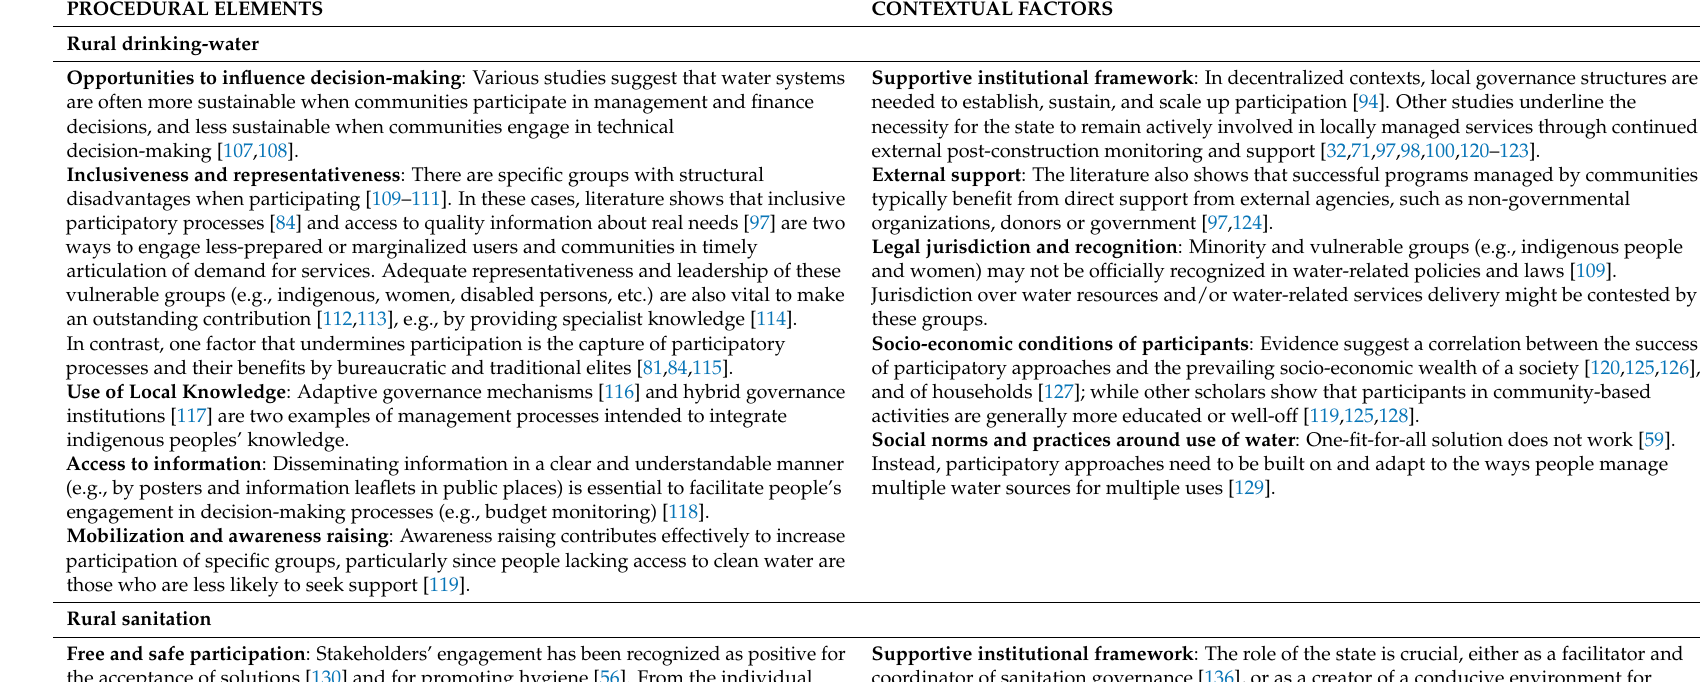
Table 2. Procedural elements and contextual factors that influence participatory outcomes and